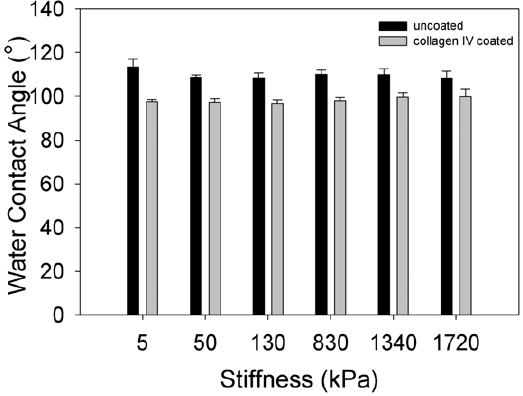
Figure 3. RMS roughness of the six PDMS formulations as a function of weight percent Sylgard 184. As the percentage of Sylgard 184 increases, the RMS roughness also increases, ranging from approximately 200 to 800 pm. While there are significant difference in roughness between formulations, all have an RMS roughness of , 1 nm, smaller than what cells can typically differentiate. Thus, we consider all the PDMS formulations to have equivalent surface roughness in terms of what a cell can sense and respond to. The relationship between RMS roughness and weight percent Sylgard 184 is fit by a linear regression (solid line, y=273.25 + 4.94x, R 2 =0.9745). Data represented as mean 6 standard deviation, statistical significance determined by one-way ANOVA on the ranks with Tukey post hoc test (n=9) where (*) was significantly different from 0, 9.09 and 16.67%, ( # ) was significantly different from 0 and 9.90% and ( { ) was significantly different from 0% Sylgard 184 formulations (p , 0.05).